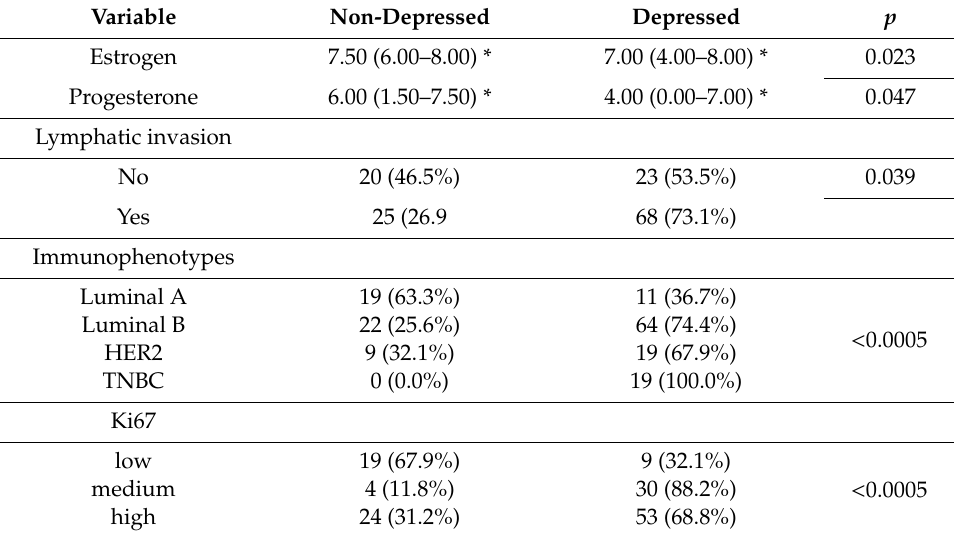
Table 3. Characteristics associated with depression expressed as medium.